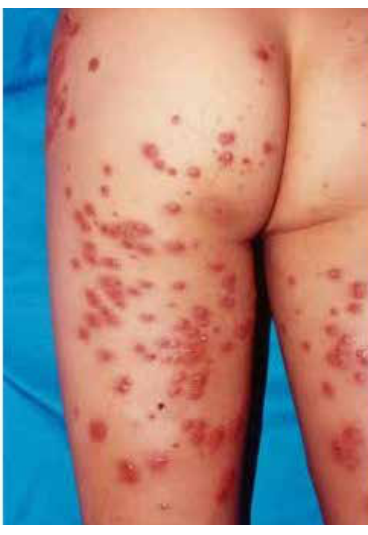
Figure 5. Staphylococcal folliculitis in